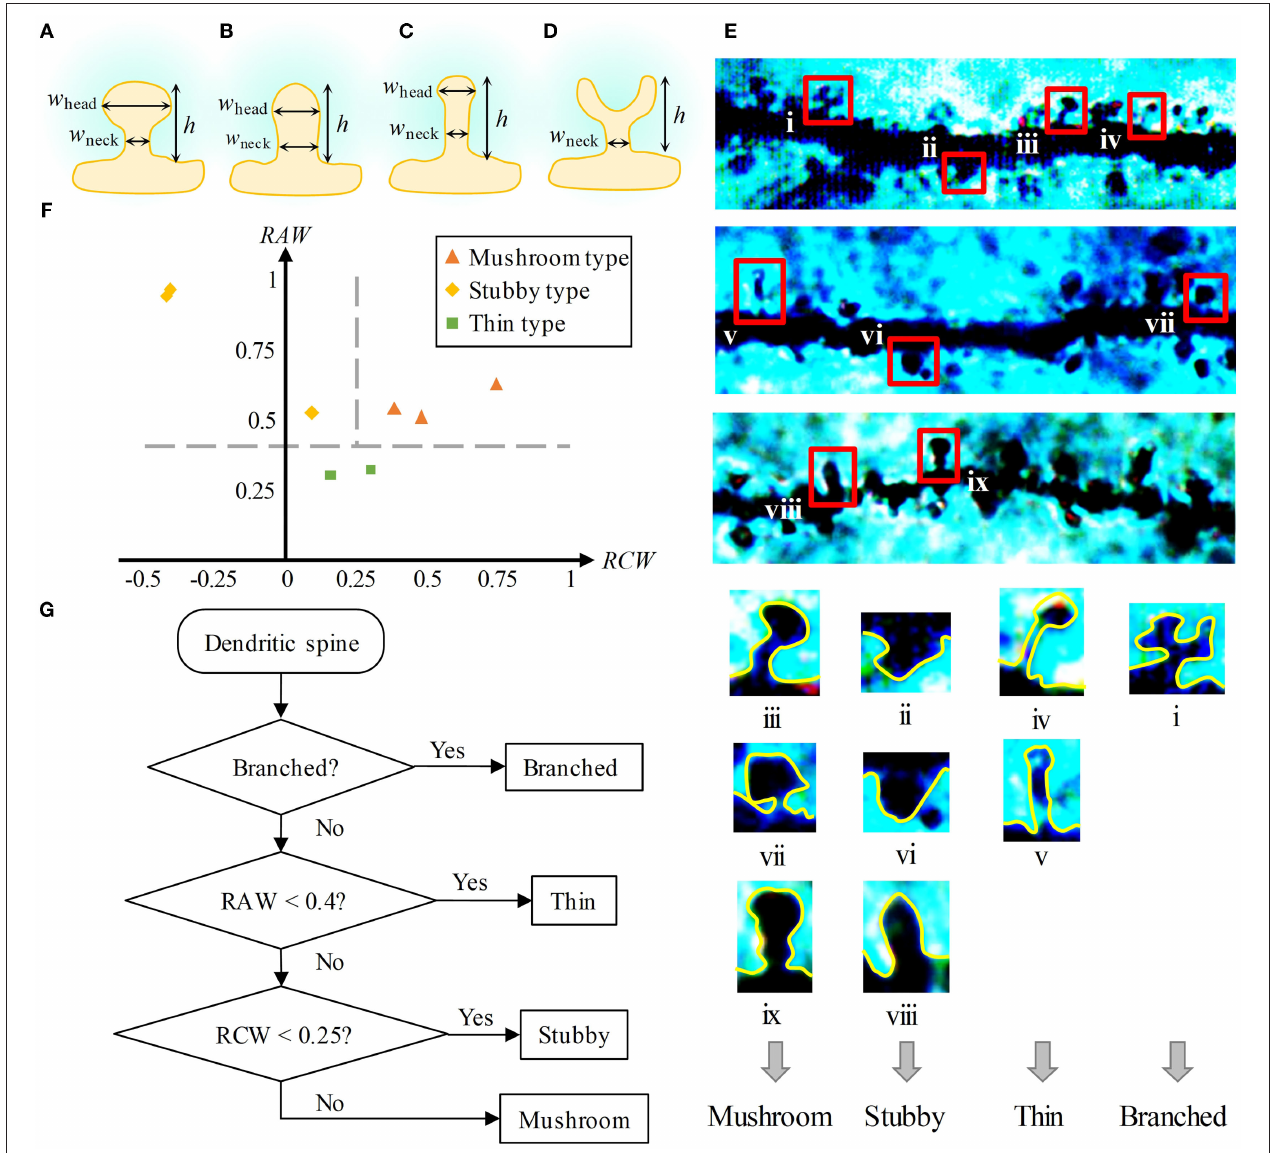
FIGURE 3 | Metrics of dendritic spine shape. (A–D) Three geometric qualities of dendritic spines, namely, the height ( h ), the extreme width of the head ( w head ), and the extreme width of the neck ( w neck ). (A) is a mushroom-type spine, (B) is a stubby-type spine, (C) is a thin-type spine, and (D) is a branched-type spine. For a branched-type spine, the extreme width of the head is meaningless. (E) Top: Golgi-Cox staining of brain slices from SD rat hippocampal CA1. Four types of spines emerge in the images. Bottom: We found nine dendritic spines (including three mushroom-type spines, three stubby-type spines, two thin-type spines, and one branched-type spine) in the above images. (F) Two-metrics distribution of mushroom-type, stubby-type, and thin-type spines. Three types can be classified by the criteria RAW = 0.4 and RCW = 0.25. (G) Flow chart of the classification method of dendritic spine shape.